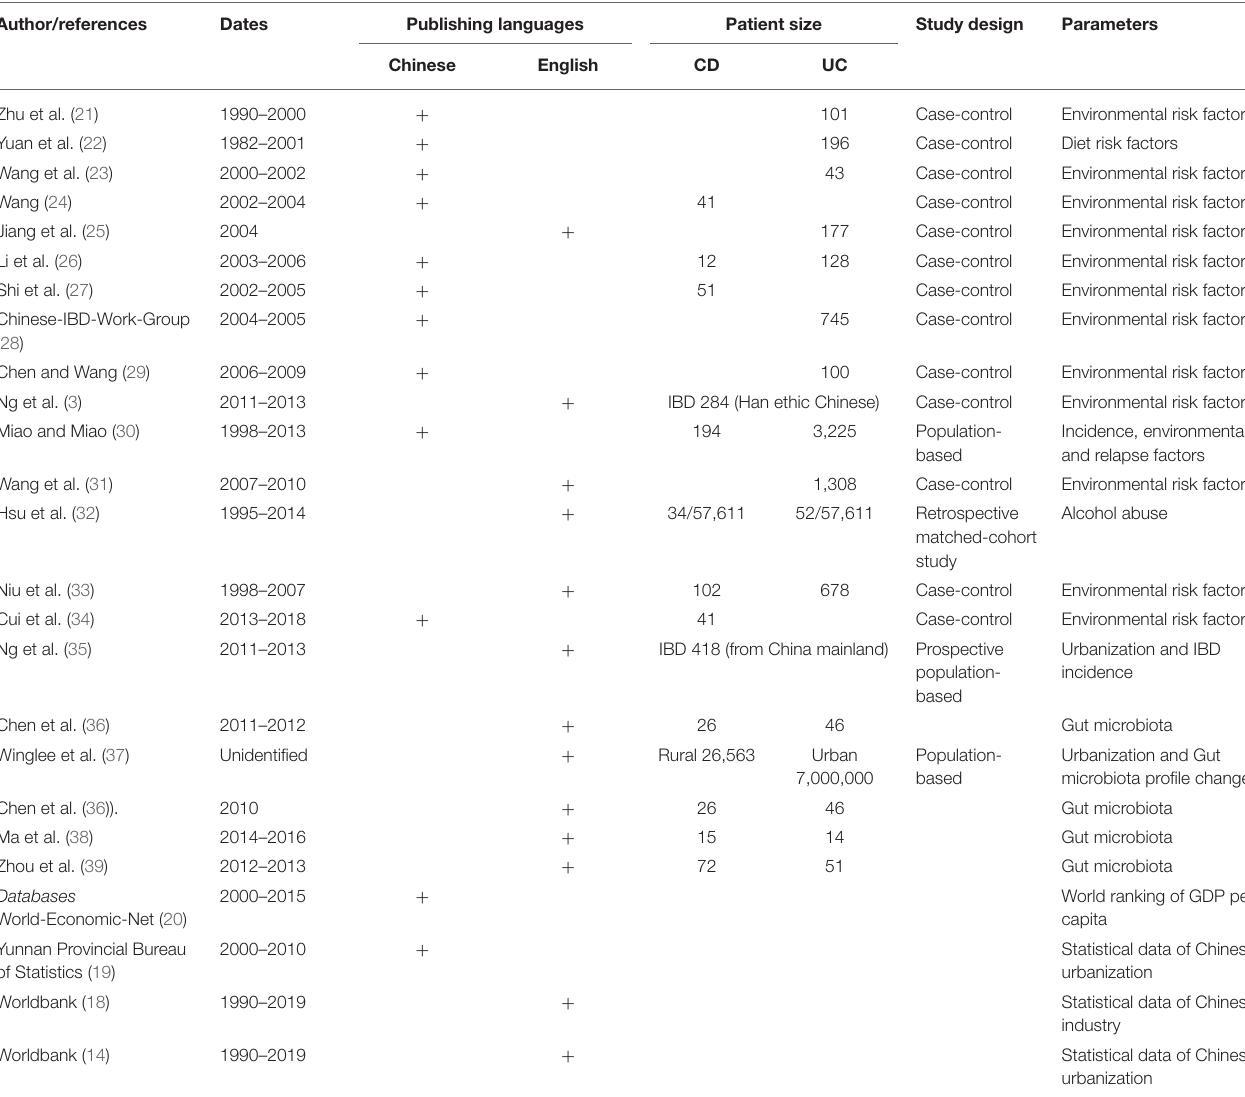
TABLE 1 | Included full-text publications and databases for this